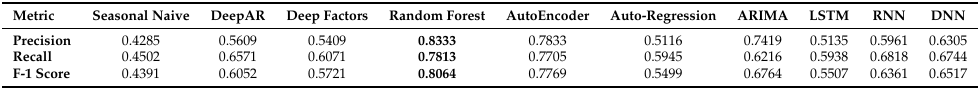
Table 2. Anomaly detection Results (Precision, Recall, and F-1 Score; the higher the better) for each forecasting model. Random Forest and AutoEncoder give the best anomaly detection